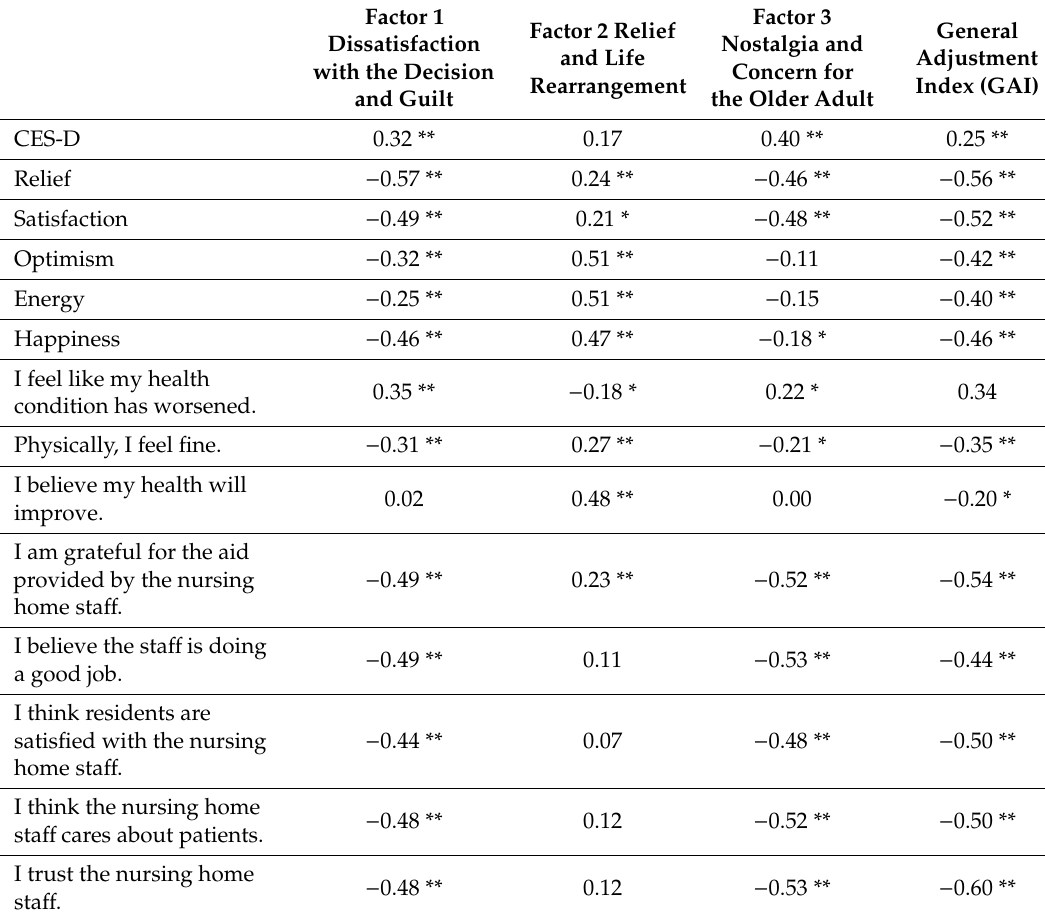
Table 5. Correlations between the scores of the CAFIAR subscales (15-item version) and CES-D, well-being indicators, health self-assessment, and satisfaction with the nursing home.